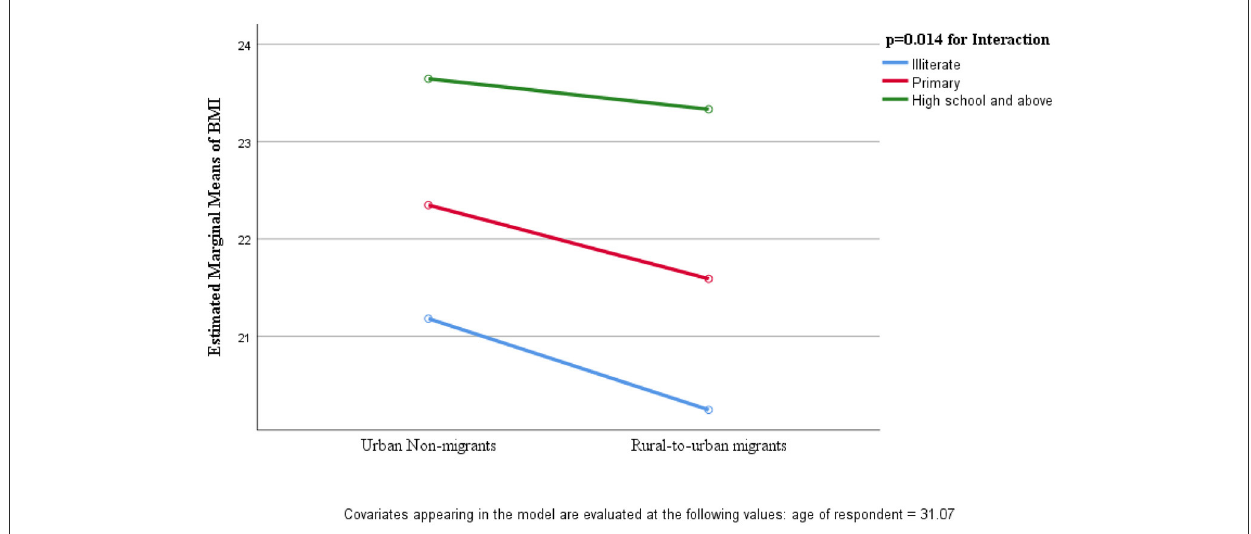
FIGURE1 Mean BMI of women by education and migration